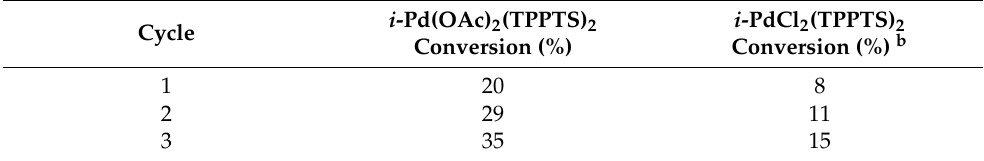
Table 2. Catalyst recycling in ethanol a .